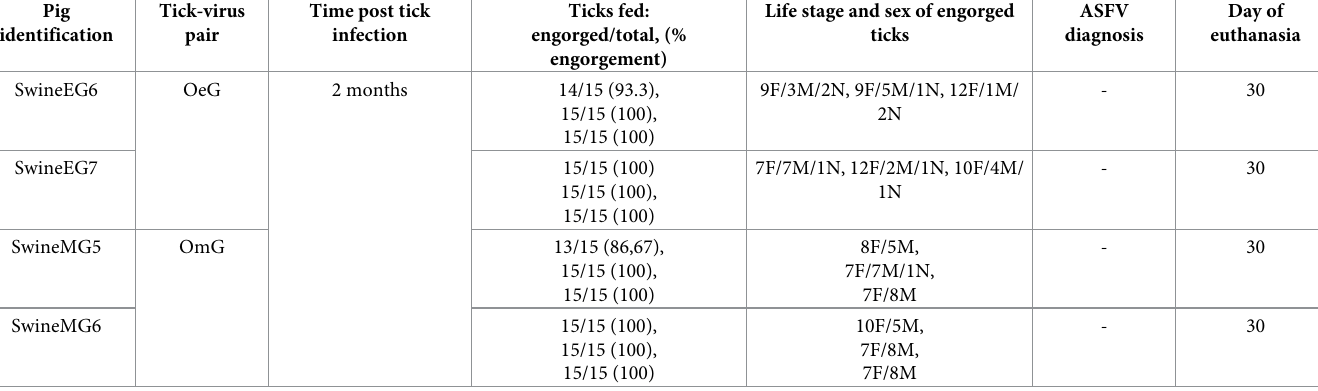
Table 5. Failure of ASFV transmission after repeated blood feeding by O . erraticus and O . moubata ticks previously exposed to selected ASFV strains. Proportions of soft ticks fed and their life stage and sex per experiment are shown. F = Female, M = male, N = Nymph. OeG = O . erraticus -Georgia2007/1, OmG = O . moubata -Geor-